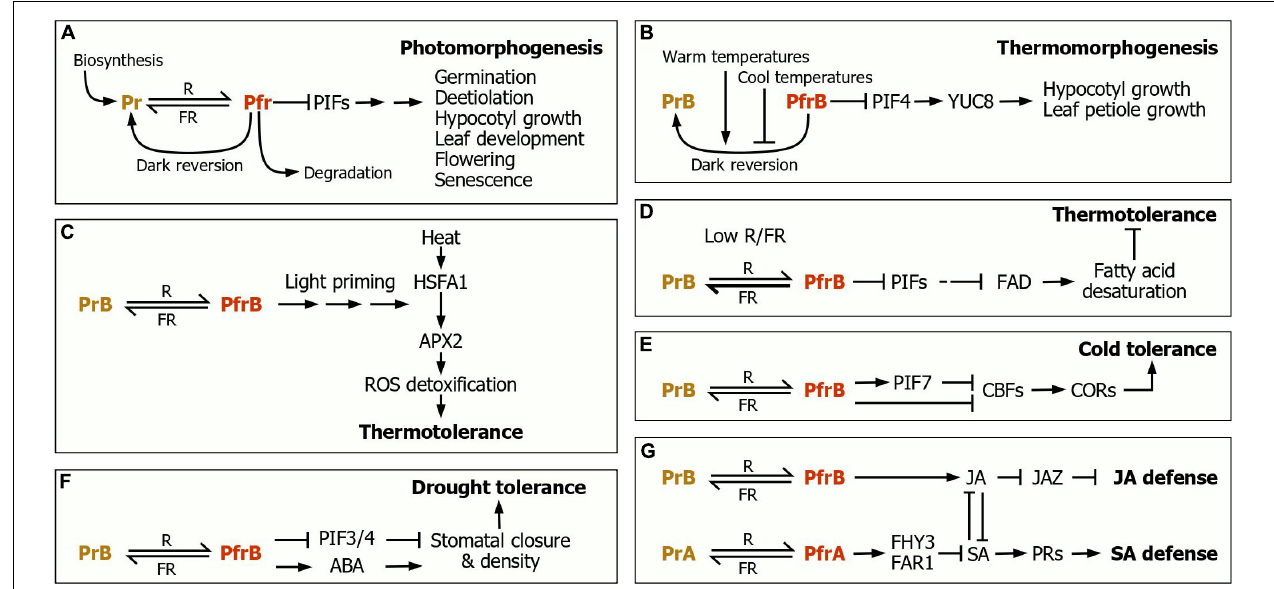
FIGURE 1 | Phytochrome control of plant morphogenic and adaptive responses. (A) Photomorphogenesis. The dynamic interconversion between the Pr and Pfr spectral forms, depending on light wavelengths, serves as a molecular switch in regulating a variety of morphogenic and developmental events, covering from seed germination to flowering and senescence. In the dark, the Pfr form is steadily converted to the Pr form, termed dark reversion. The phytochrome function is also regulated at the steps of its biosynthesis and degradation. (B) Thermomorphogenesis. The PfrB-to-PrB dark reversion is accelerated at warm temperatures but delayed at cool temperatures. The thermomorphogenesis promoter PIF4 activates the expression of the YUC8 auxin biosynthetic gene, leading to the promotion of hypocotyl and leaf petiole growth. (C) Light priming of thermotolerance response. The PfrB signals prime the induction of the APX2 gene, whose gene product detoxifies ROS, leading to the induction of thermotolerance. (D) Enhancement of thermotolerance under plant canopy. Under this severe shade condition, low R/FR shifts the phyB photoconversion toward PrB, and thus the FAD expression is repressed, leading to the reduction of fatty acid desaturation and the resultant enhancement of thermotolerance. (E) Light regulation of cold tolerance. The CBF-COR regulon plays a key role during cold acclimation. Under high R/FR, the PfrB form, in conjunction with PIF7, suppresses the expression of the CBF genes, leading to the reduction of cold tolerance. In contrast, under low R/FR, as frequently encountered during twilight in the fall season, the phyB photoconversion is shifted toward Pr, leading to the activation of the CBF-COR regulon. (F) The phyB-mediated regulation of drought tolerance. The PfrB form increases stomatal density and induces stomatal closure. Under drought conditions, where ABA biosynthesis is elevated, the PfrB signals increase ABA sensitivity/responsiveness. These signaling cascades cause the enhancement of drought tolerance. (G) The phytochrome control of defense responses. The phytochrome-mediated light signals regulate SA biosynthesis and perception to induce the expression of PR genes during SA responses. Under shade conditions, JA-mediated defense responses are attenuated via a JAZ-mediated transcriptional control. The JA and SA responses are linked through signaling